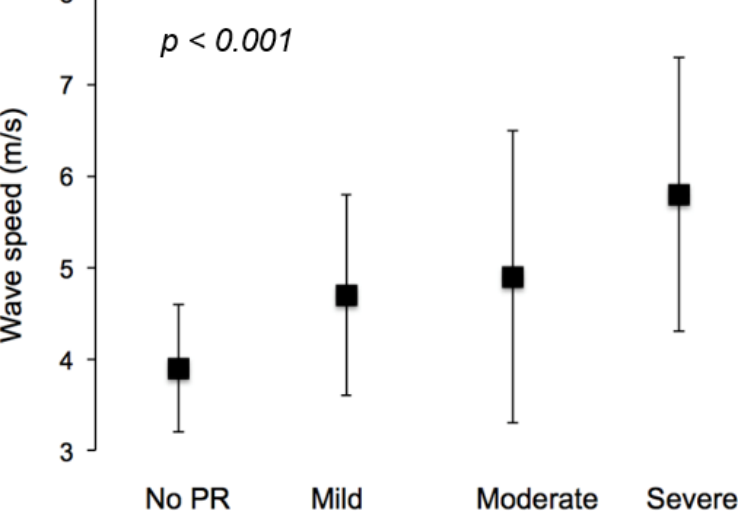
Figure 3. ToF-repaired patients exhibited increasing wave speed with increasing PR